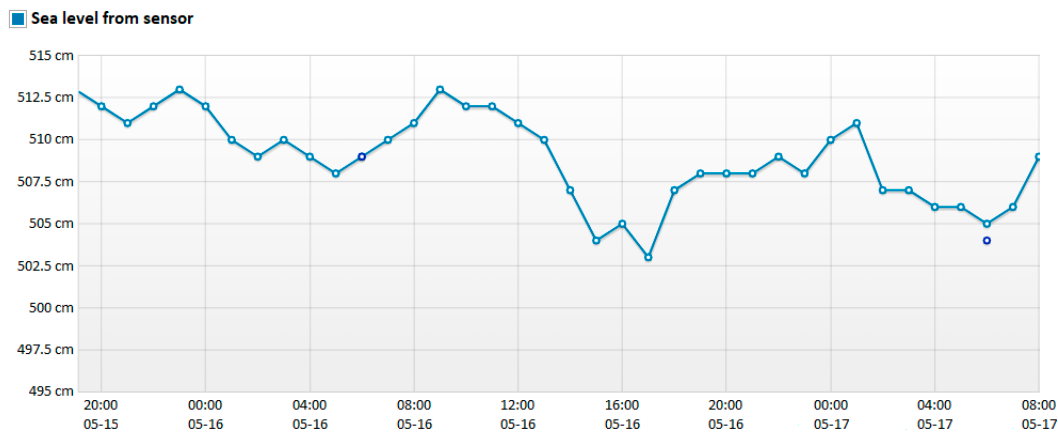
Figure 7. A diagram of sea level variability observed on a tide gauge in Gdynia according to the IMGW-PIB weather service.